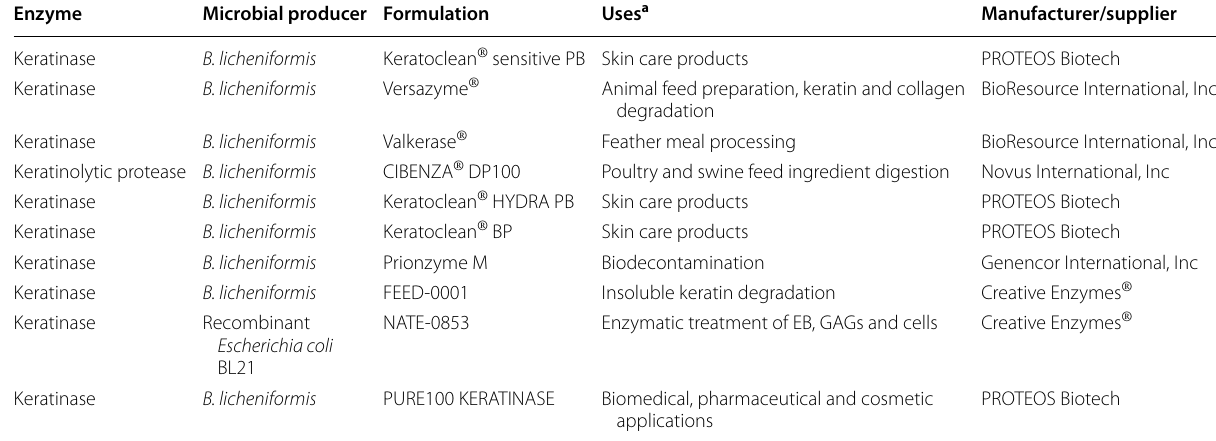
Table 4 Keratinase–based formulation in commercial use (some information were adapted from Hassan et al. 2020 and Srivastava et al.